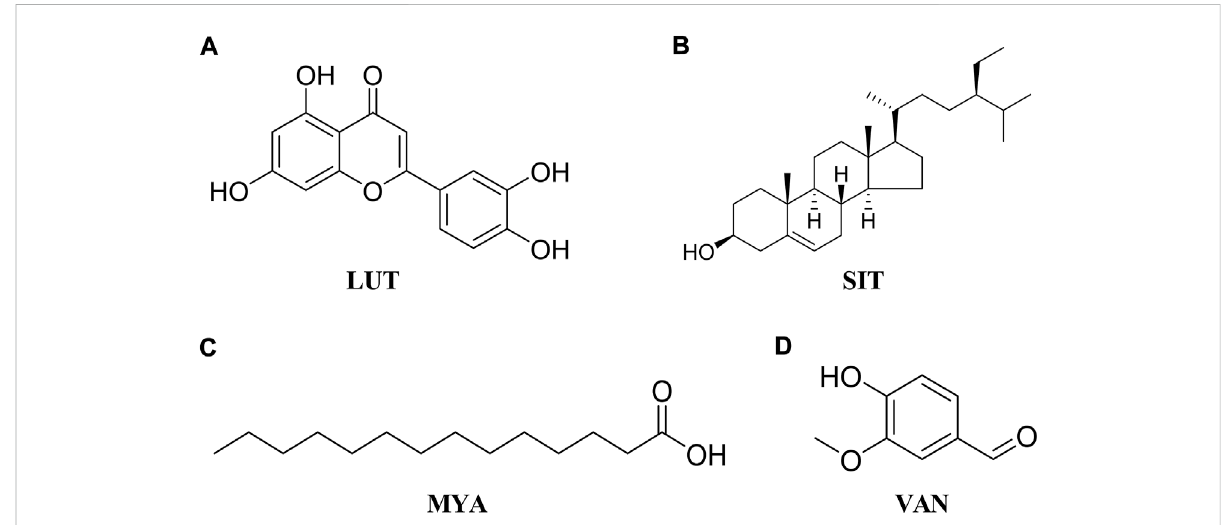
FIGURE 2 Chemical structure of LUT (A) , SIT (B) , MYA (C) , and VAN (D)